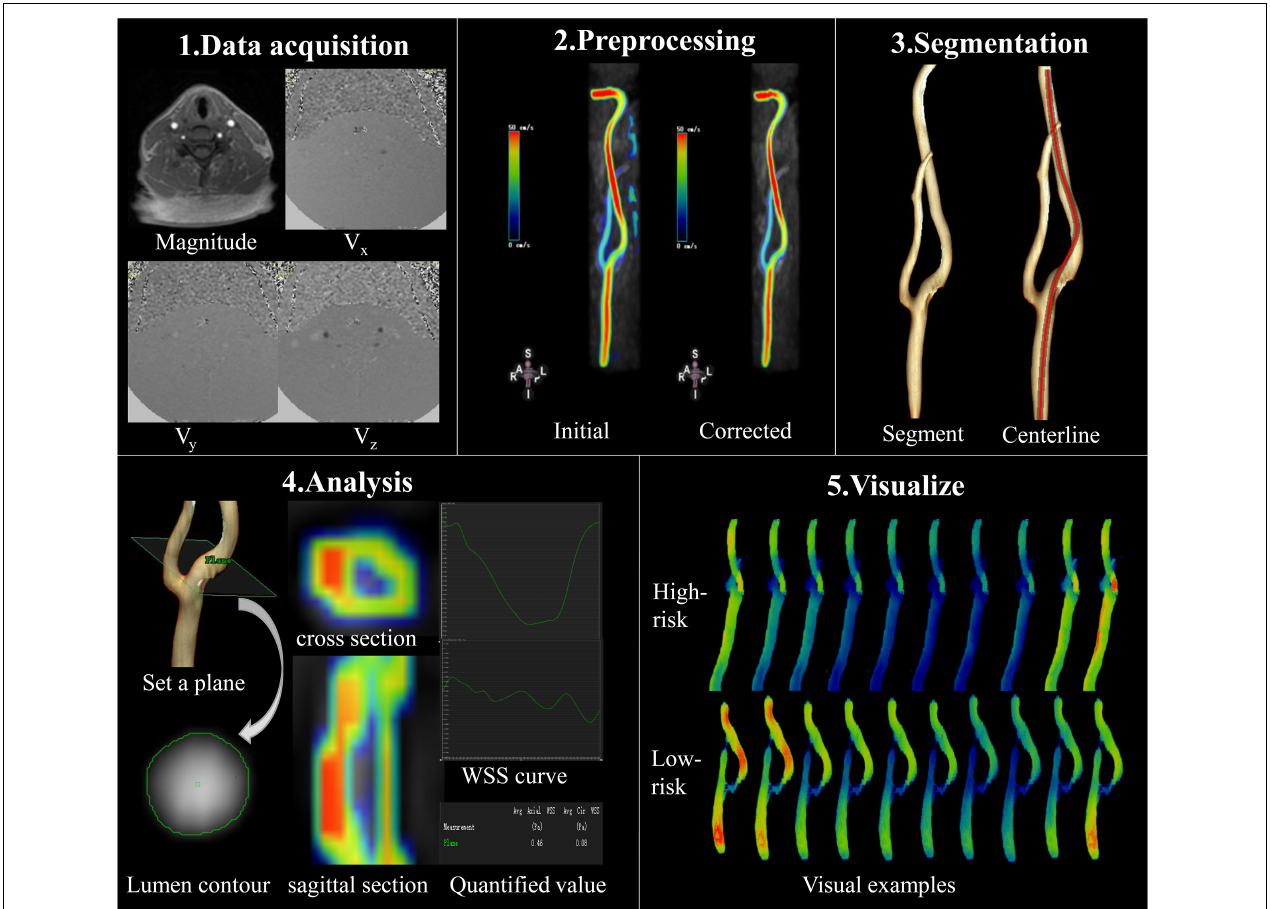
FIGURE 3 | Data acquisition and analysis workflow for 4D flow MRI. (1) Data acquisition: PC-MRI with three-directional velocity information is collected. (2) Preprocessing: data preprocessing corrects for errors due to noise, aliasing, and eddy current. (3) Segmentation: the centerline was segmented parallel traced along the target vessel. (4) Analysis: the plane is set at the narrowed segment of the lumen and segment of the lumen contour in magnitude-coded image manually, then we can get the cross section and sagittal section visually, as well as the axial and circumferential WSS curve and the quantified values. (5) Visualize: examples of WSS evaluated by 4D flow MRI at different time points; 4D flow MRI can display hemodynamic changes dynamically and visually in different cardiac cycles.